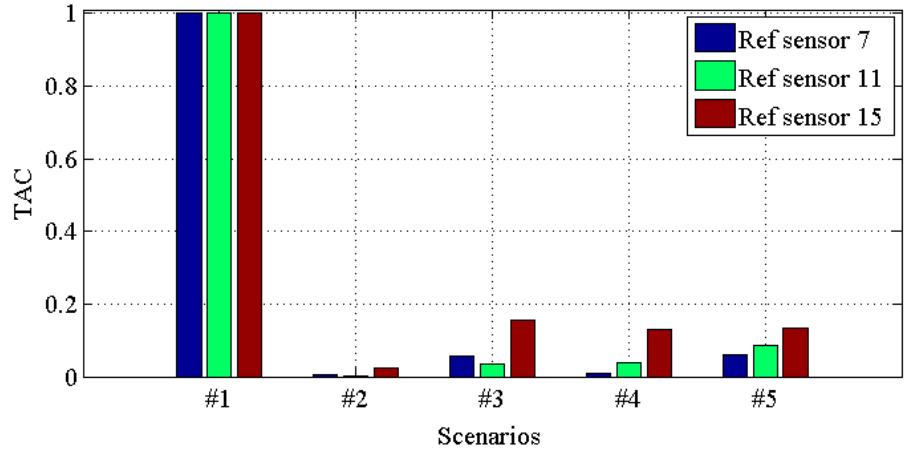
Figure 16. TAC for transmissibilities T(3, :), T(7, :), T(11, :) and T(15, :) with reference sensor 7, 11 and 15 for damage scenario #1 to #5.